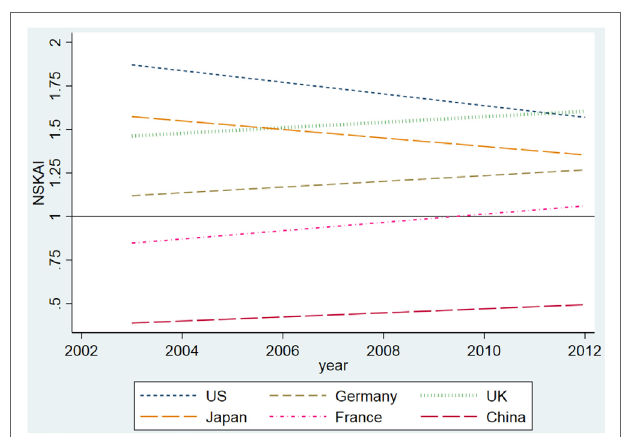
FigUre 3 | Standardized scientific knowledge application index by country and by year. Note: The trend is plotted by lfit function in a linear regression. Original data for each year can be found in Figure A1 in Supplementary Material.